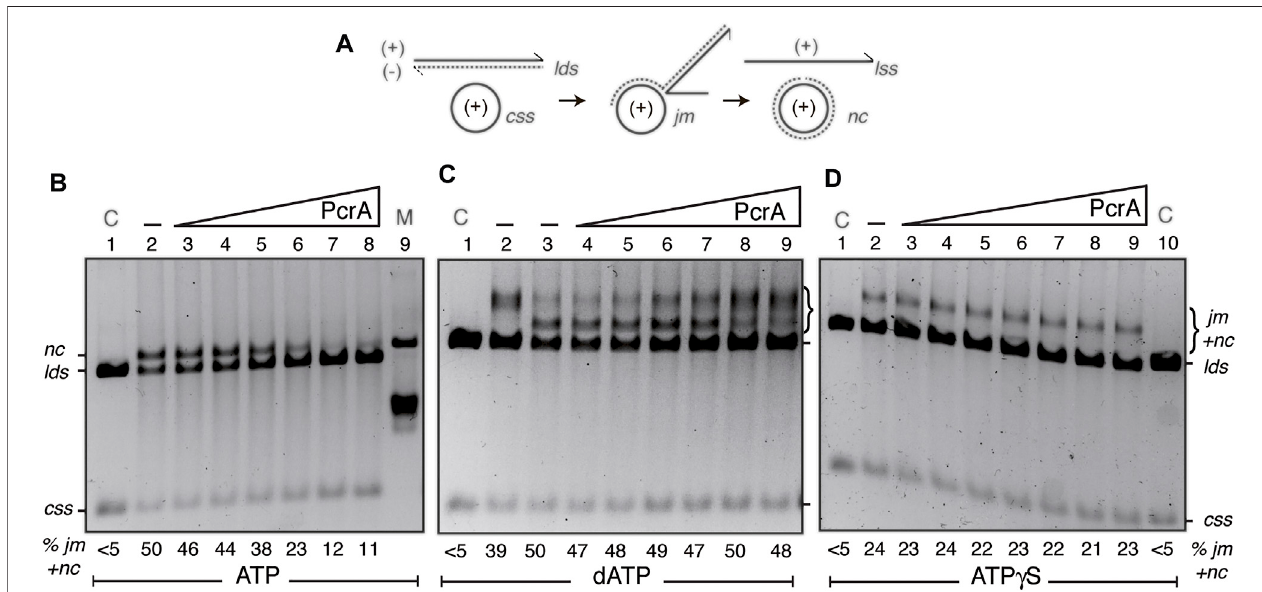
FIGURE 5 | PcrA inhibits RecA-mediated DSE. (A) Cartoons illustrating the substrates, intermediates, and products of the three-strand exchange reaction upon RecA-mediated DSE. (B,D) The cssDNA (10 μ M in nt) was pre-incubated with SsbA (300 nM) and RecO (100 nM) in buffer A (for 5 min at 37 ° C). Then, increasing PcrA (3 – 100 nM)[B-D])and fi xedRecA (800 nM), lds (10 μ Minbp), andATP (B) orATP γ S (D) (5 mM)concentrationswereadded,and thereaction wasincubated for60 min at 37 ° C. (C) The cssDNA wasincubated with increasing PcrA(1.5 – 100 nM), fi xed RecA, lds , and dATP (5 mM)concentrations for 60 min at 37 ° C. The products of the reactions were deproteinized, separated on a 0.8% AGE with ethidium bromide, and quanti fi ed as described in Materials and Methods. The positions of the bands corresponding to css , cds , lds , jm, nc , and ATP γ S-generated prd products are indicated. Symbols - denote the absence of PcrA. In (B,D) , lanes 1 and 10, the cssDNA andthe lds substratesaredenotedascontrol (C), andinA(lane9),nickedcircularpGEM3Zf(+)plasmidDNAwasaddedasamobilitycontrolofthe nc product.The%of jm sand products ( nc and prd ) areindicatedand expressed asthepercentage oftotal substrate added. Theresults arethe averagevalueobtained from more than three independent experiments, and representative gels are shown here (the results given stand within a 5% standard